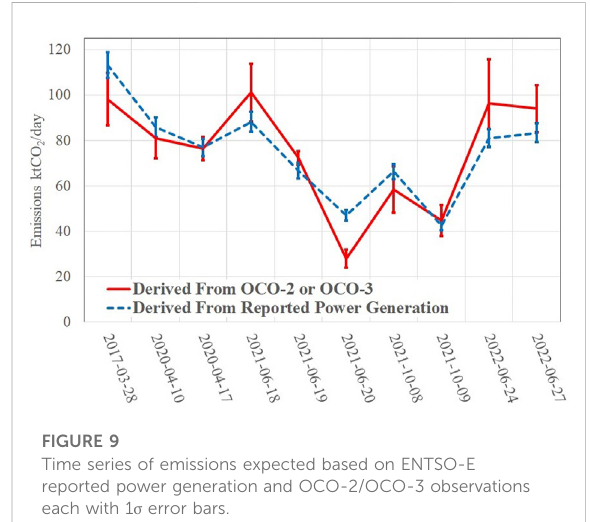
FIGURE 9 Time series of emissions expected based on ENTSO-E reported power generation and OCO-2/OCO-3 observations each with 1 σ error